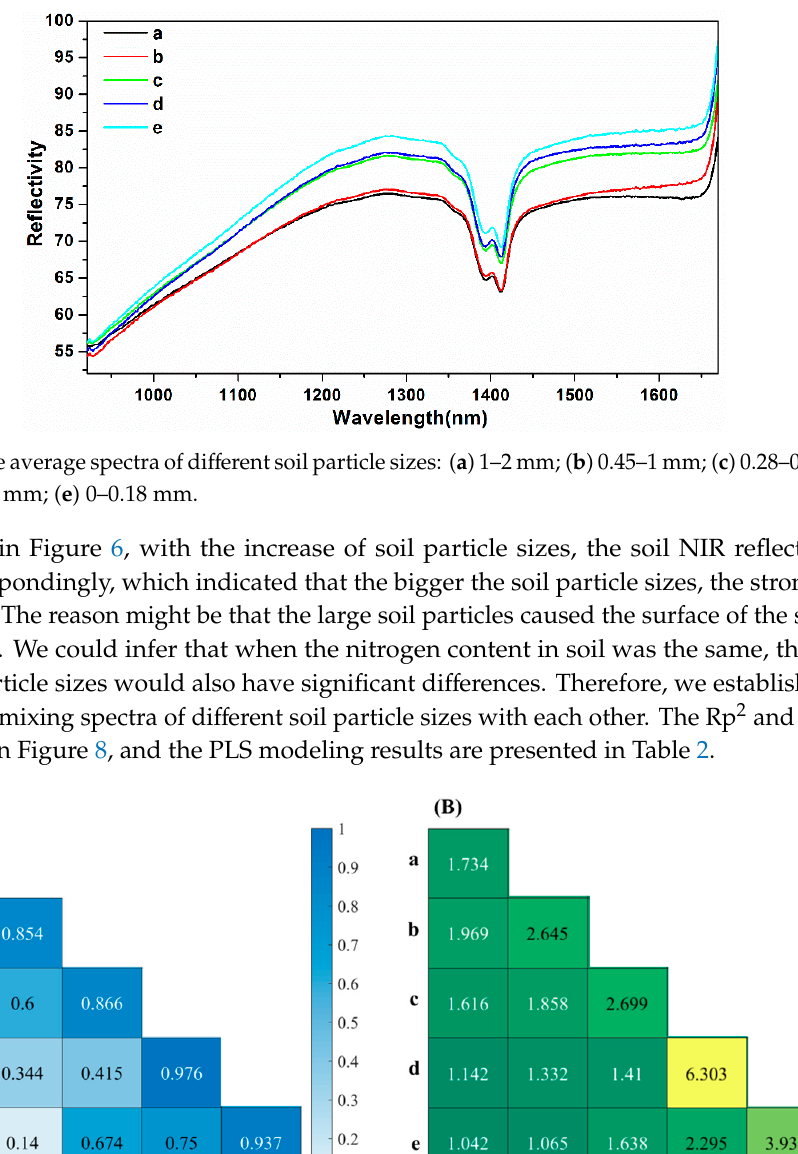
Table 2. The PLS model prediction of different soil particle sizes. Particle Size (mm)